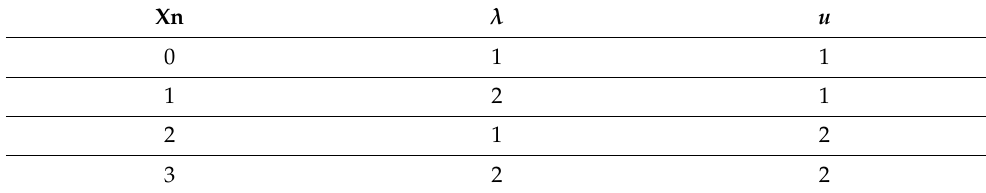
Table 2. Values of λ and u